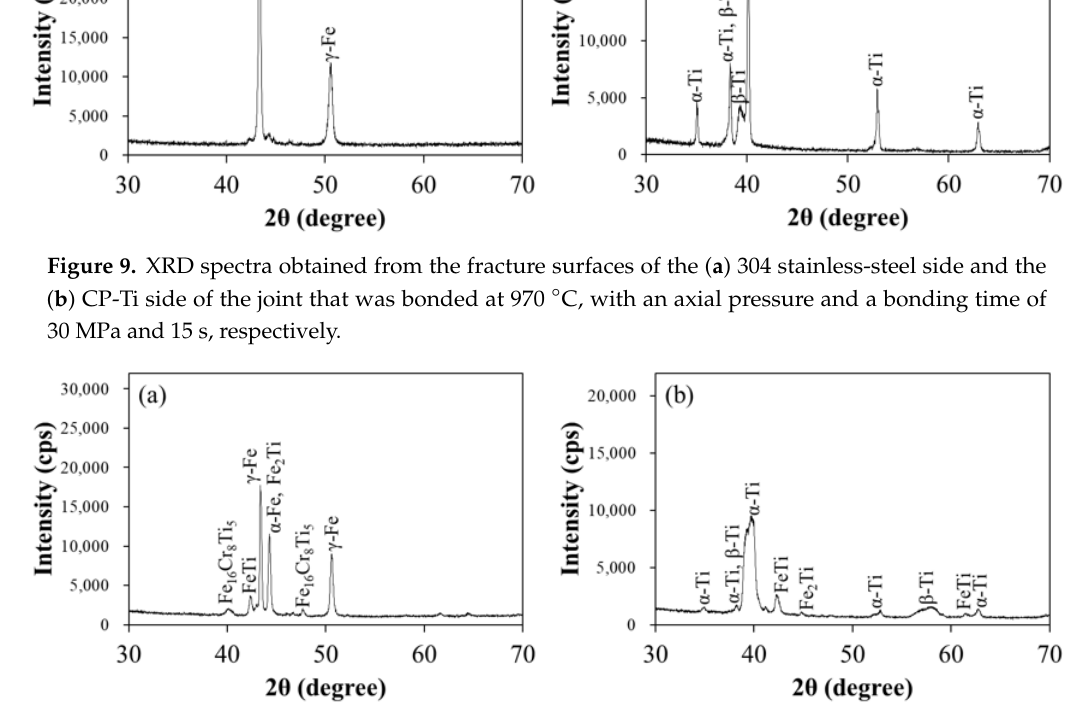
Figure 10. XRD spectra obtained from the fracture surfaces of the ( a ) 304 stainless-steel side and the ( b ) CP-Ti side of the joint that was bonded at 1160 °C, with an axial pressure and a bonding time of 30 MPa and 15 s, respectively.